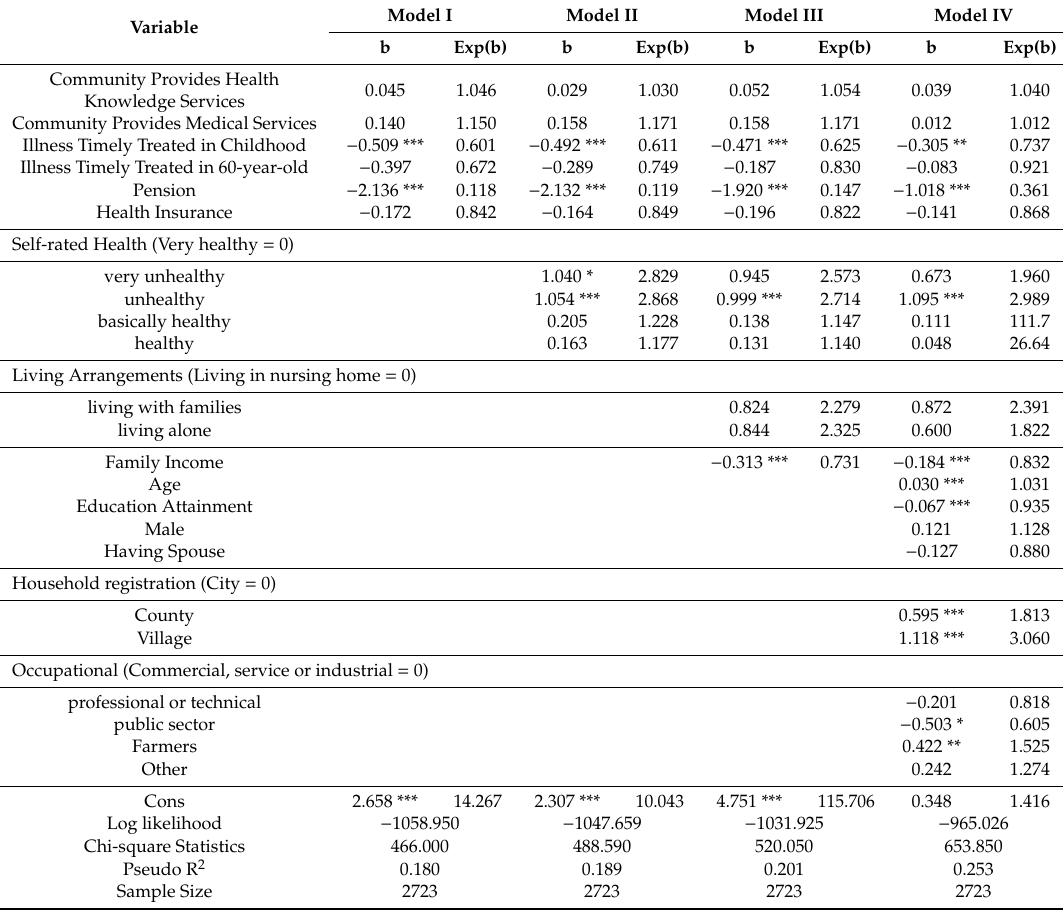
Table 8. Bivariate regression of the influencing factors of elderly’s health behaviors